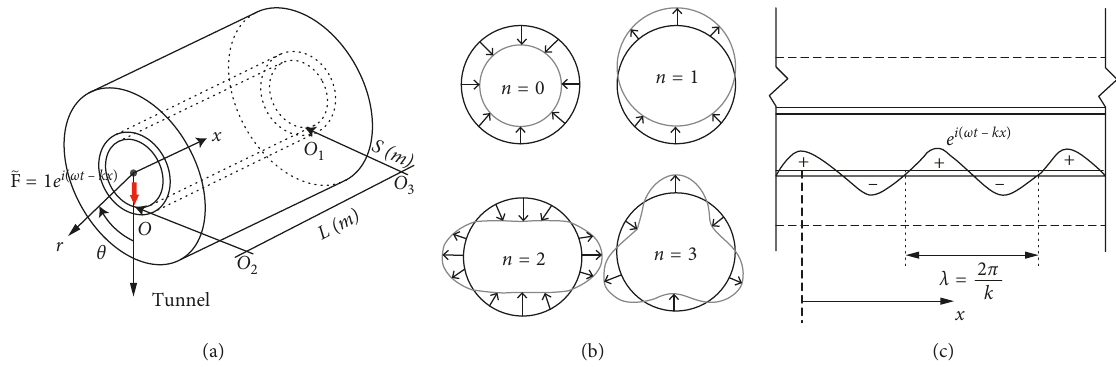
Figure 12: Decomposition of a radial line load and the resulting tunnel response: (a) the first four Fourier components in cross section; (b) schematic map of the steady response system of the tunnel structure; (c) spatial distribution along the x direction [31].